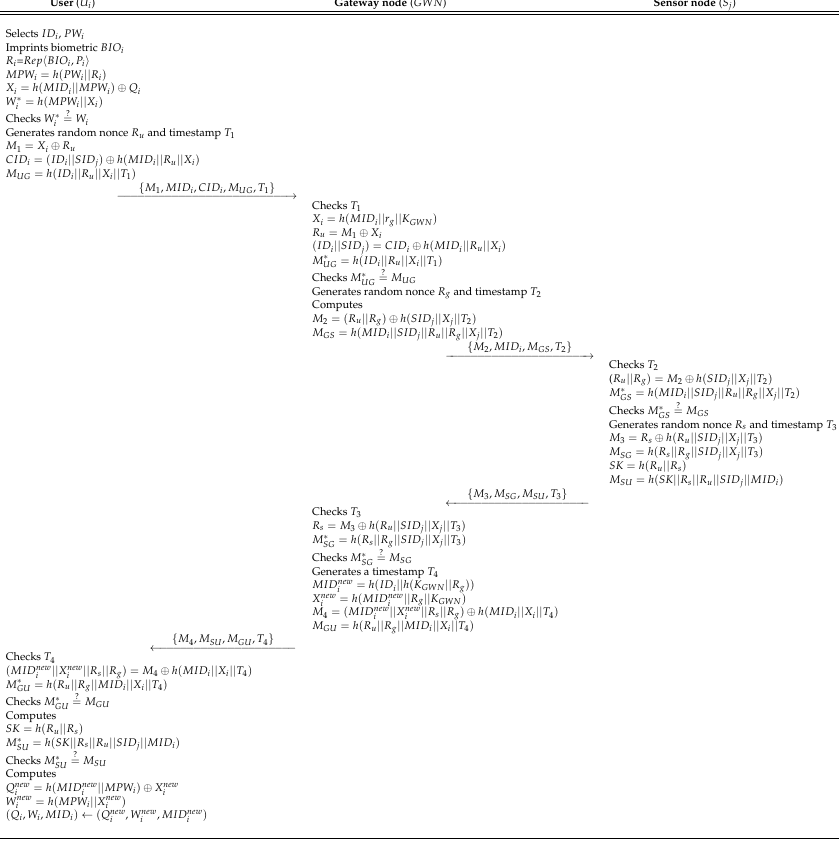
Figure 6. Authentication process of our